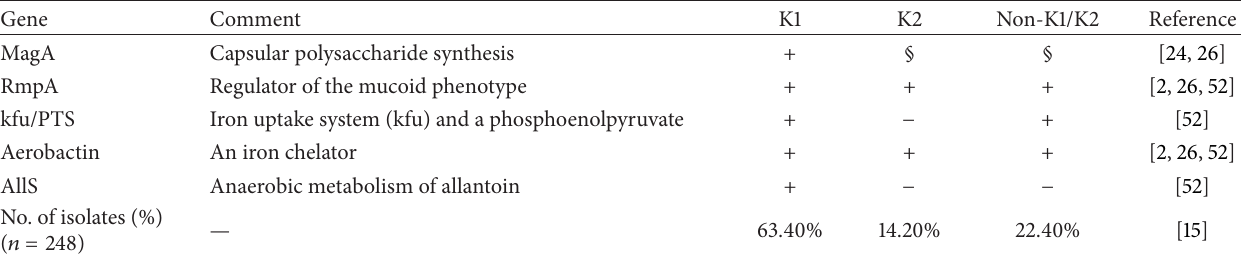
Table 2: Genes associated with the serotypes of K . pneumonia